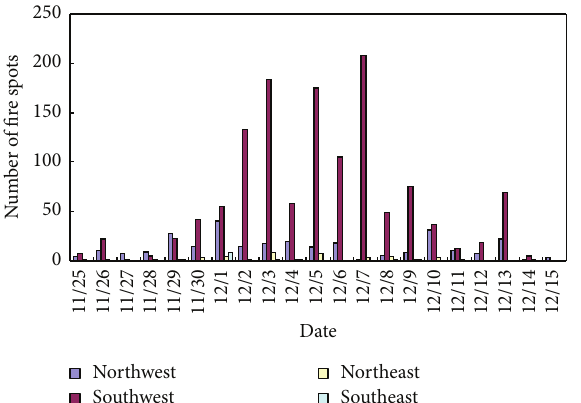
Figure 2: Daily numbers of fire spots in different sectors: northwest sector: 100 ∘ E–119.733 ∘ E, 30.3 ∘ N–48 ∘ N; southwest sector: 100 ∘ E–119.733 ∘ E, 22 ∘ N–30.3 ∘ N; northeast sector: 119.733 ∘ E–130 ∘ E, 30.3 ∘ N–48 ∘ N; and southeast sector: 119.733 ∘ E–130 ∘ E, 22 ∘ N–30.3 ∘